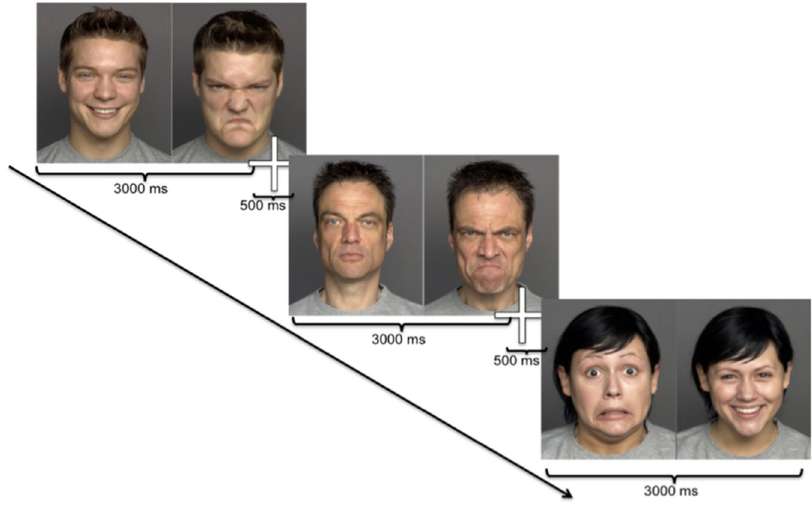
Figure 7. Temporal sequence of the presentation of human facial expressions. Each stimulus consisted of two portrayal pictures and was presented for 3000 ms, followed by a fixation stimulus (500 ms), before the next stimulus appeared. For human facial expressions, each stimulus (from FACES 63 ), consisted of two pictures of the same individual showing two different out of four facial expressions (fear, anger, happiness, or